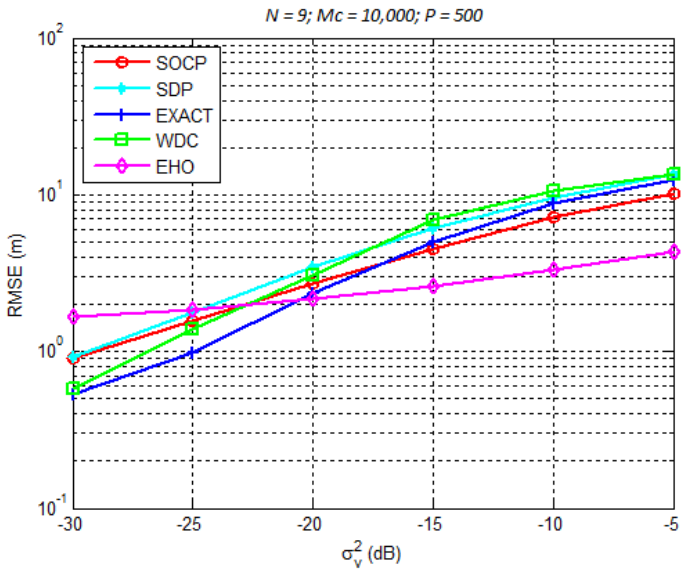
Figure 8. RMSE (m) versus σ 2 ν